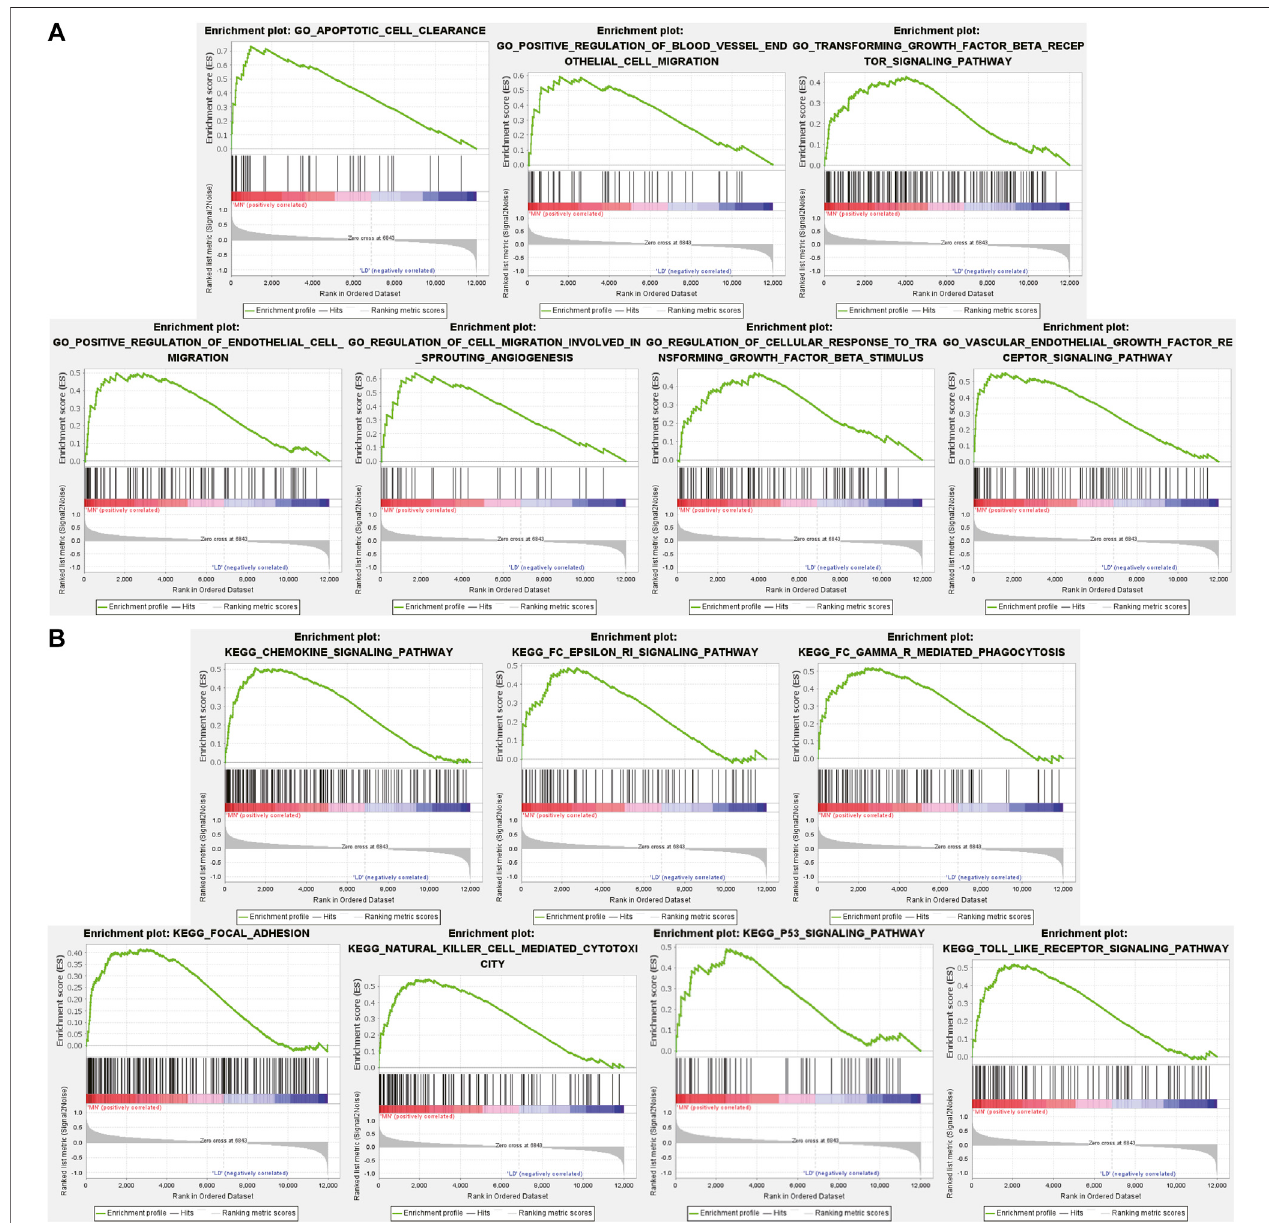
FIGURE3| GSEA plotshowingmostenriched GOterms and KEGGpathwaysintheMN group. (A) .The7most signi fi cantenriched GOtermpositivelycorrelated with the MN group was apoptotic cell clearance, positive regulation of blood vessel endothelial cell migration, transforming growth factor beta receptor signaling pathway, positive regulation of endothelial cell migration, regulation of cell migration involved in sprouting angiogenesis, regulation of cellular response to transforming growthfactorbetastimulus,vascularendothelialgrowthfactorreceptorsignalingpathway. (B) The7mostsigni fi cantenrichedKEGGpathwaypositivelycorrelated with the MN group was chemokine signaling pathway, Fc ε Ri signaling pathway, Fc γ R mediated phagocytosis, focal adhesion, natural killer cell mediated cytotoxicity, p53 signaling pathway, toll like receptor signaling pathway. MN, membranous nephropathy; GSEA, GO term enrichment analysis; GO, gene ontology; KEGG, Kyoto Encyclopedia of Genes and